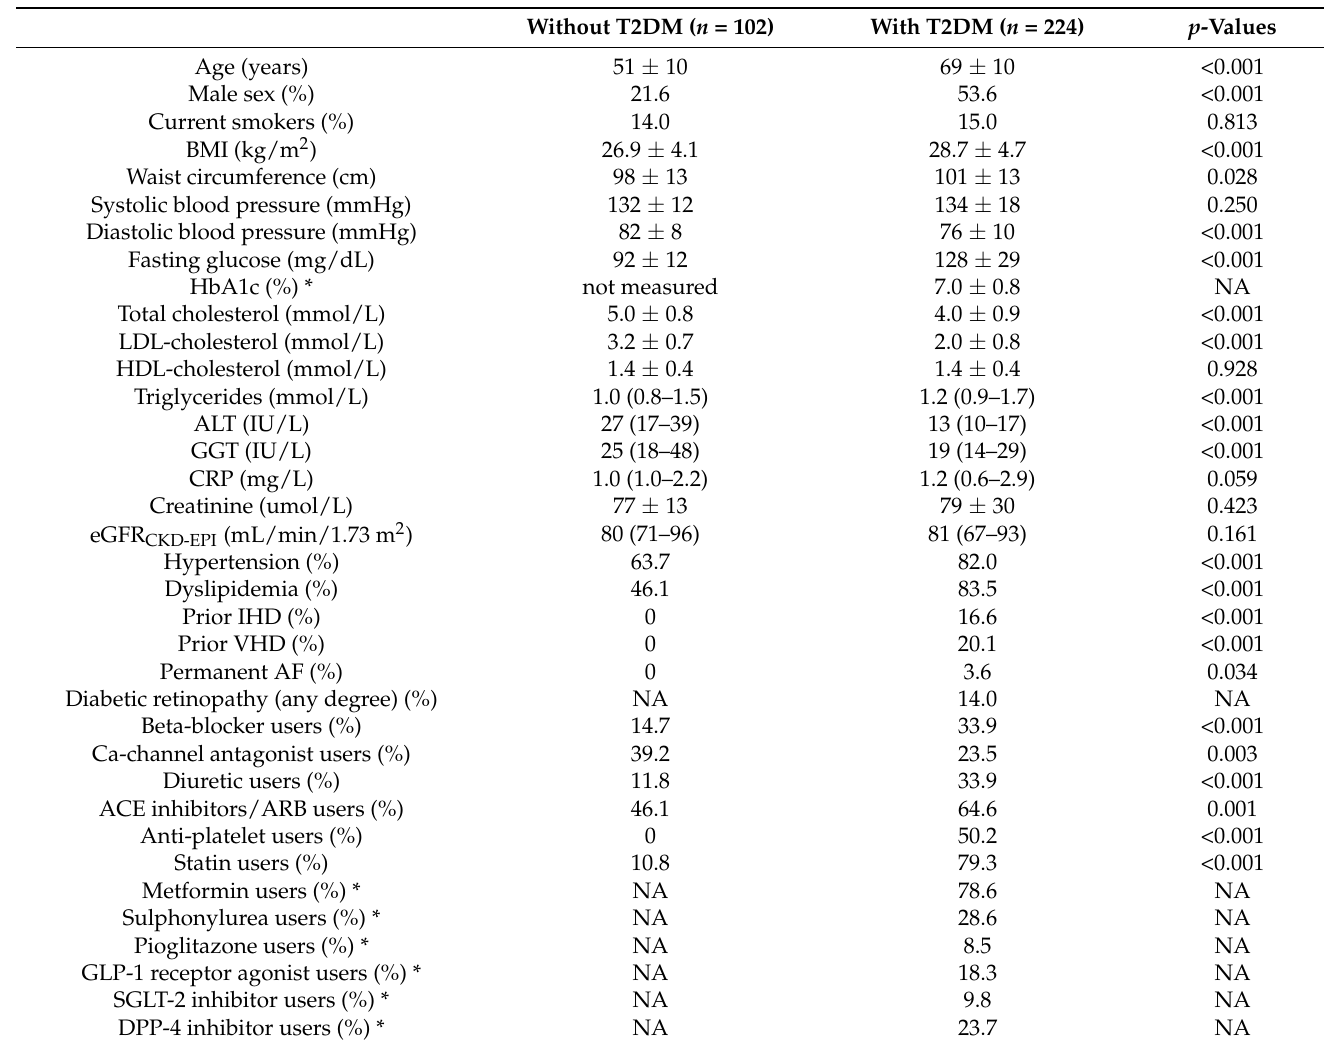
Table 1. Main clinical and biochemical characteristics of patients stratified by presence/absence of type 2 diabetes melli- tus